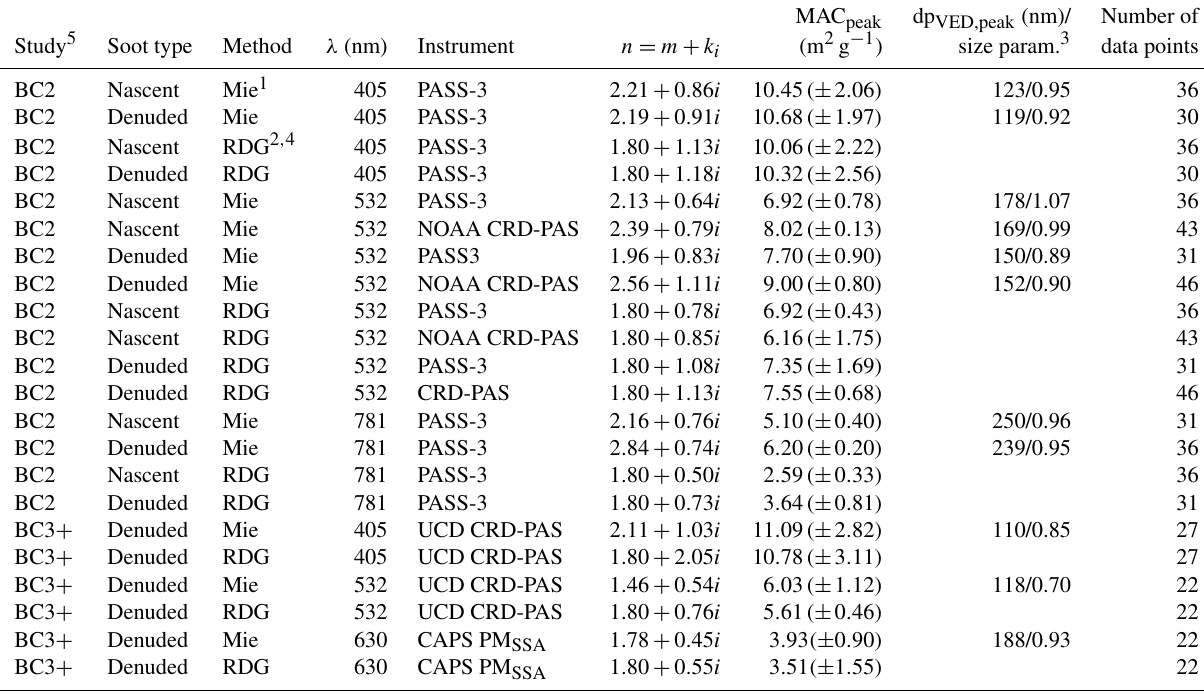
Table 2. Theory-specific effective refractive indices for ethylene premixed flame soot from BC2 and BC3 + retrieved via fitting Mie theory and the RDG approximation to the σ abs observations. Nascent and denuded experiments are considered